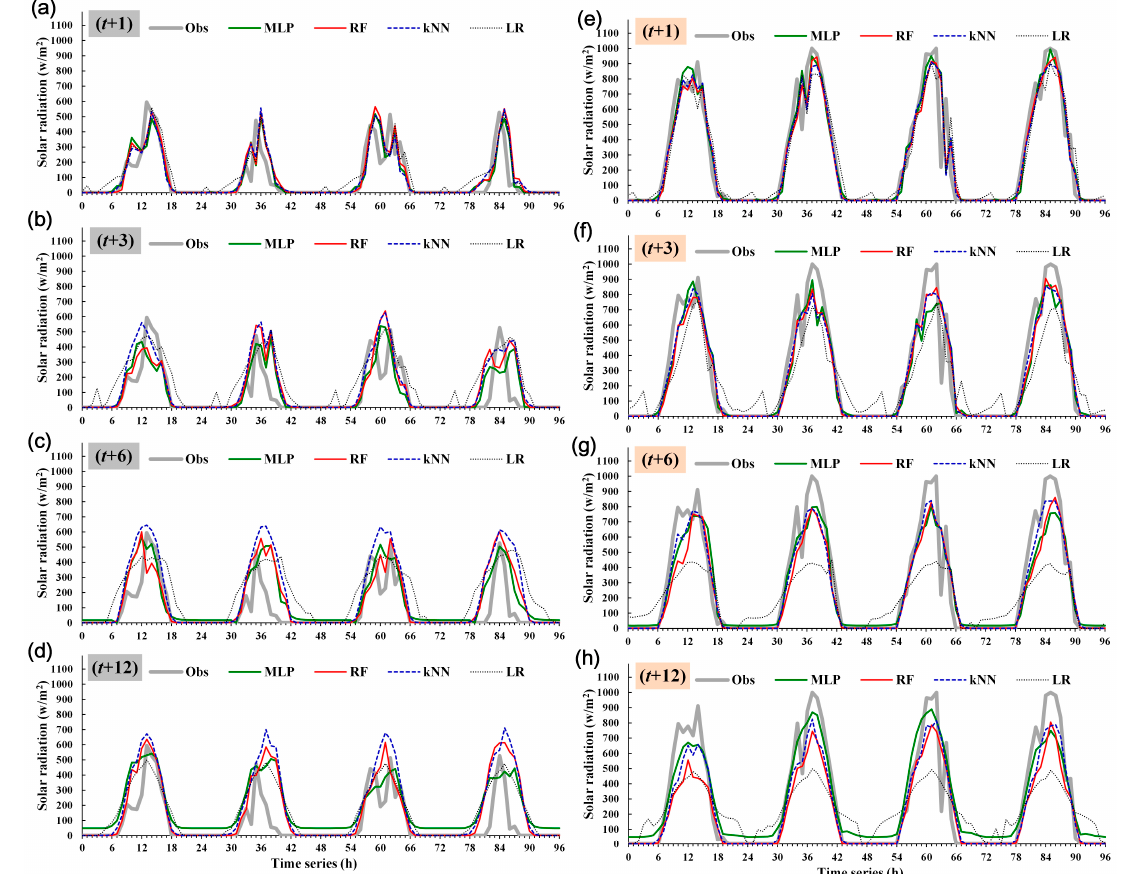
Figure 8. Observed and predicted changes in solar irradiance for the 4 consecutive days within 1 h ( t + 1), 3 h ( t + 3), 6 h ( t + 6), and 12 h ( t + 12) starting from: ( a – d ) the vernal equinox on 20 March 2016,